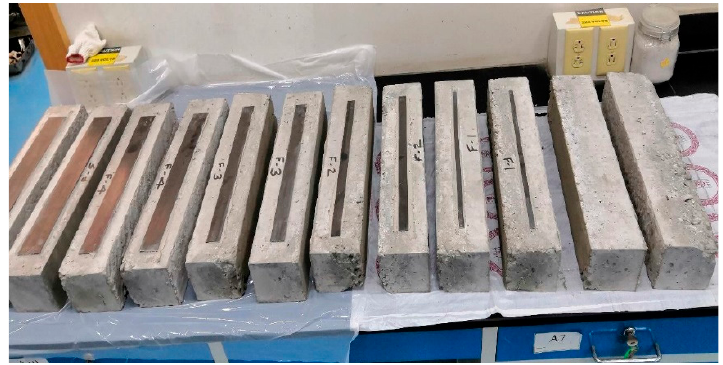
Figure 4. Completely prepared test specimens.